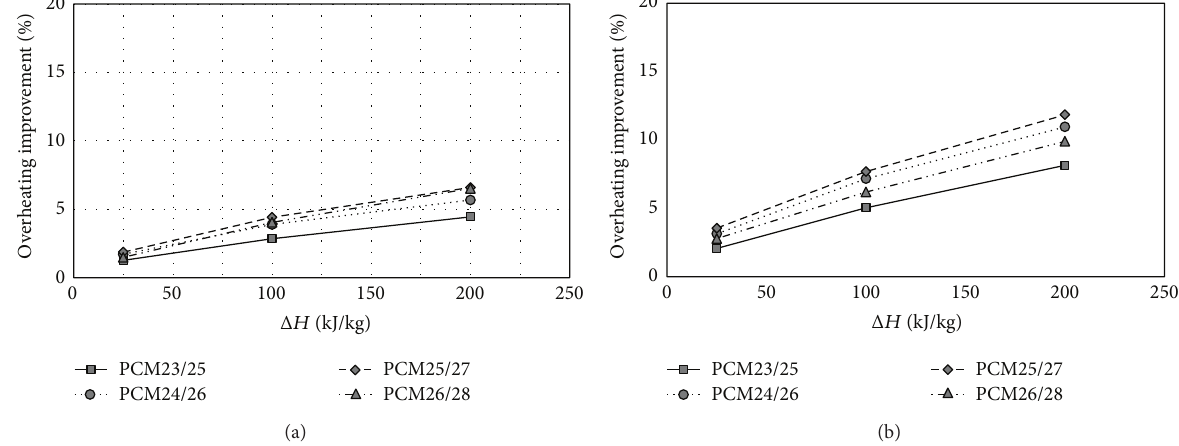
between the use of REFM as plastering in the office cell and the use of different PCMM. Attending to the analysis for “free-floating” situation, with a 25 ∘ C basis for DH to assess the discomfort due to overheating, with results plotted in Figure 6, maximum overheating improvement was 12%, obtained for the office cell placed in Porto with PCM25/27 200. The lowest value was registered for the office cell placed in Lisbon for PCM23/25 25 (a PCM with an enthalpy of 25 kJ/kg and a fusion temperature range between 23 and 25 ∘ C). Still, the overheating improvement was